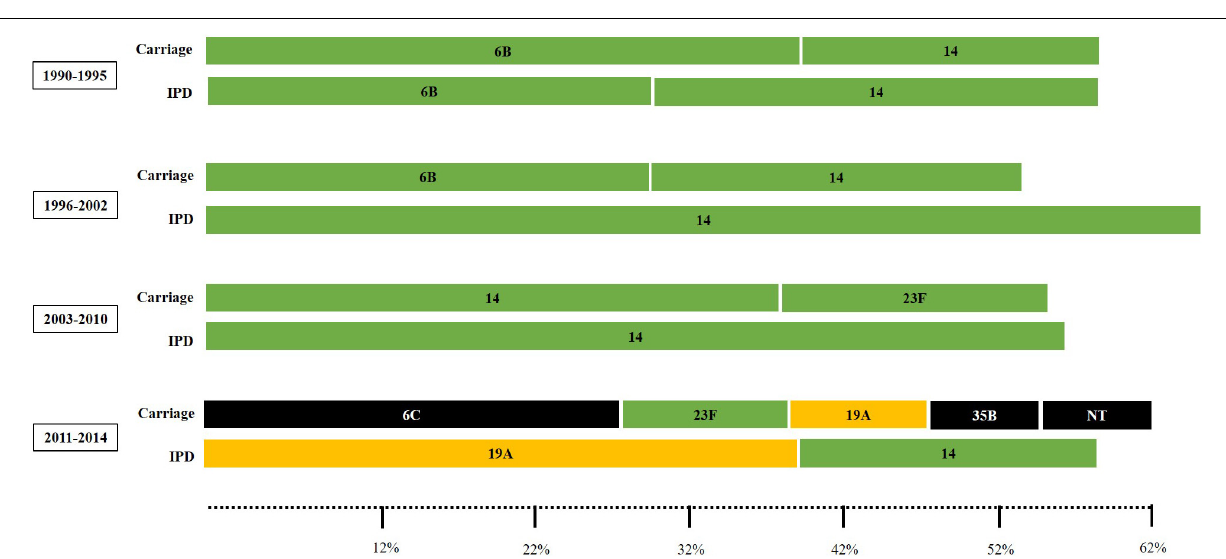
FIGURE 5 | Sets of the most common pneumococcal capsular types associated with penicillin non-susceptibility (comprising 50 to 60% of the pneumococcal isolates) according to the clinical source and period of time. Carriage isolates included those recovered from nasopharynx or oropharynx specimens while IPD isolates included those recovered from blood or cerebrospinal fluid. Serotypes colored in green are included in the 10-valent pneumococcal conjugate vaccine (PCV); those colored in yellow are only included in the 13-valent PCV; and those colored in black are not included in any PCV currently